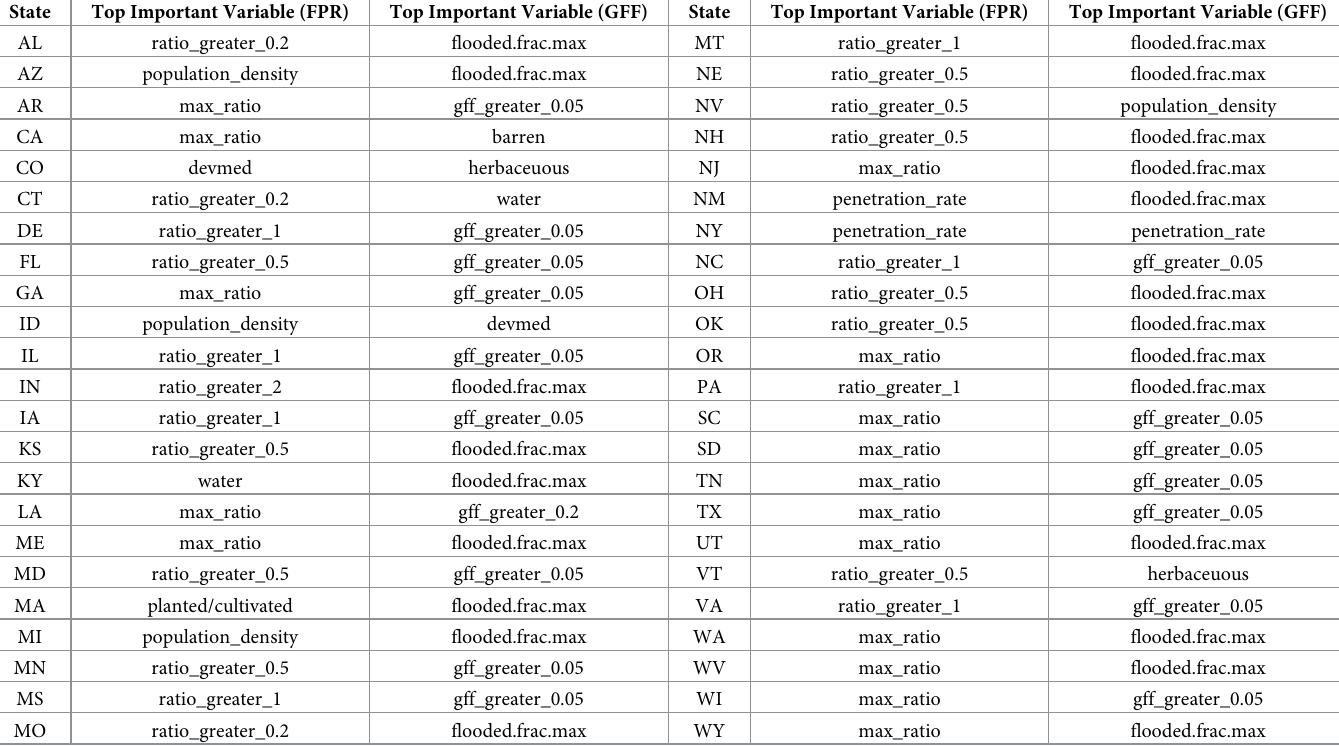
Table 4. The most important variable, in terms of error reduction, for each state in statewide analysis. See S1 Table for a description of variables and abbreviations.